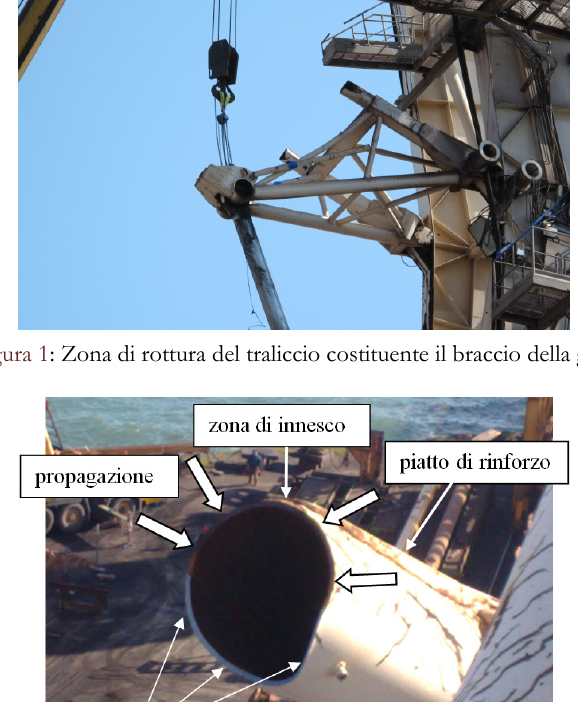
F. Frendo, Frattura ed Integrità Strutturale, 12 (2010) 48-56; DOI: 10.3221/IGF-ESIS.12.05